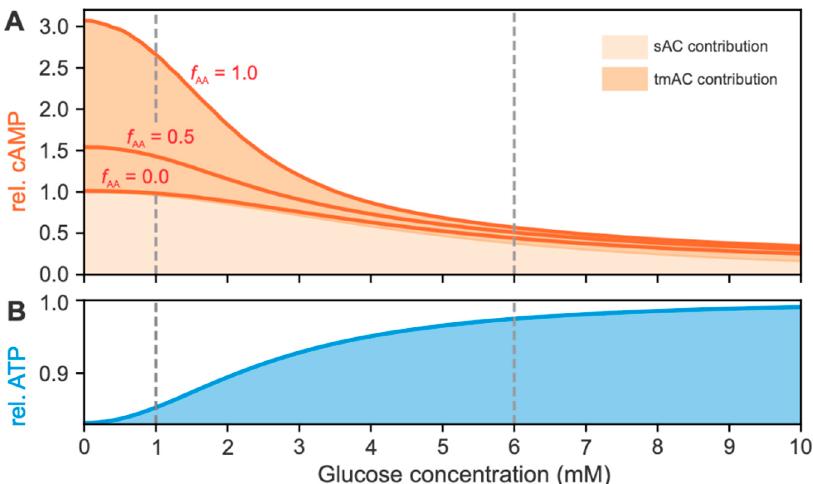
Figure 3. Glucose-dependent intracellular cAMP and ATP concentrations. ( A ) The cAMP concen- tration is composed of the sAC (light orange) and tmAC (dark orange) contributions. The sAC contribution is invariant with changes in AA concentration. The tmAC contribution increases sig- nificantly at low glucose concentration and high AA concentration. ( B ) ATP concentration is only glucose-dependent and increases by ~20% with hyperglycemia.